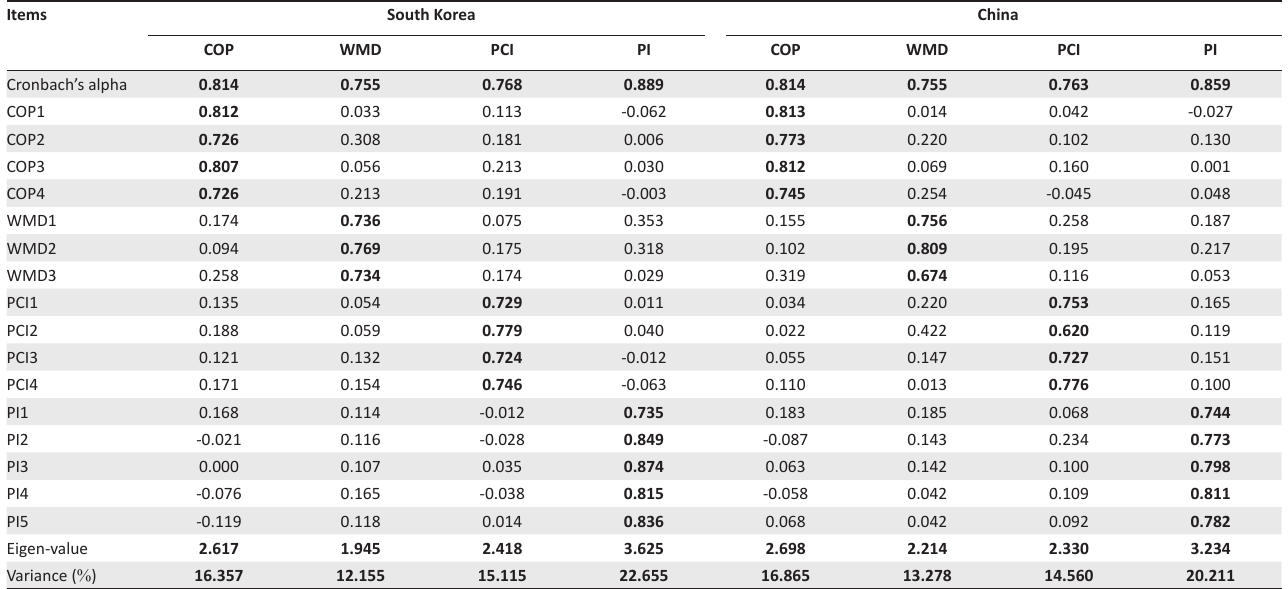
TABLE 5: Validity and reliability test results.